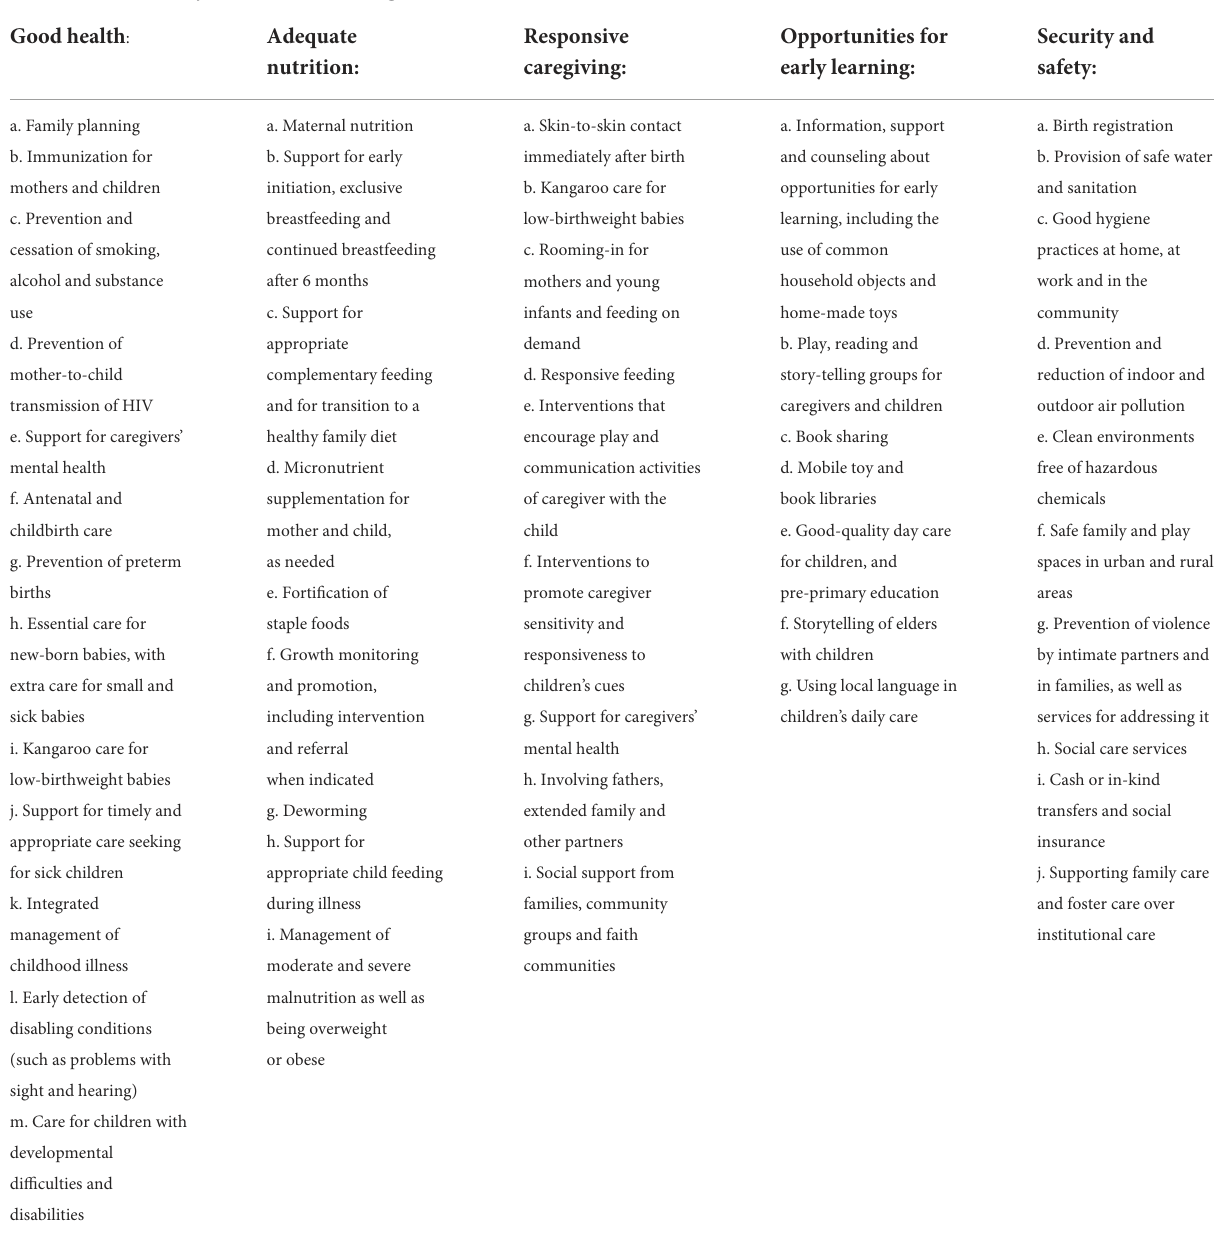
TABLE 1 Detailed components of the nurturing care framework (1). Good health